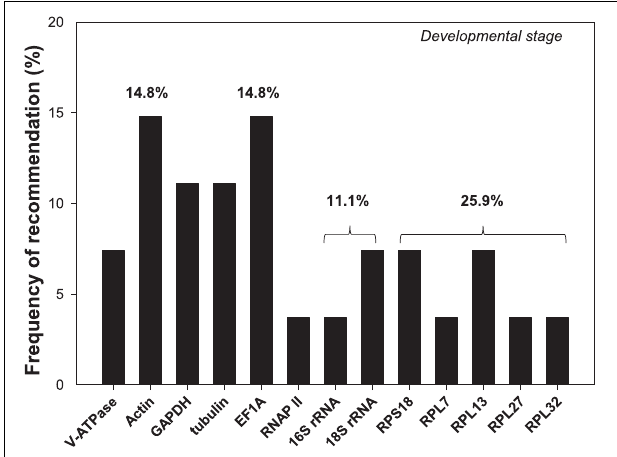
FIGURE 6 | Frequency of reference genes recommended for the cell-content feeding arthropod pests. Here we surveyed the frequency of each reference gene recommended for different developmental stages among the nine cell-content feeding arthropod species, including four spider mites, A. viennensis, Tetranychus urticae, Tetranychus cinnabarinus, and Panonychus citri, and five hemipterans, Myzus persicae, Aphis gossypii, Toxoptera citricida, Lipaphis erysimi, and Sogatella furcifera . Reference genes (top three) recommended for each species under different developmental stages are detailed in Supplementary Table S2